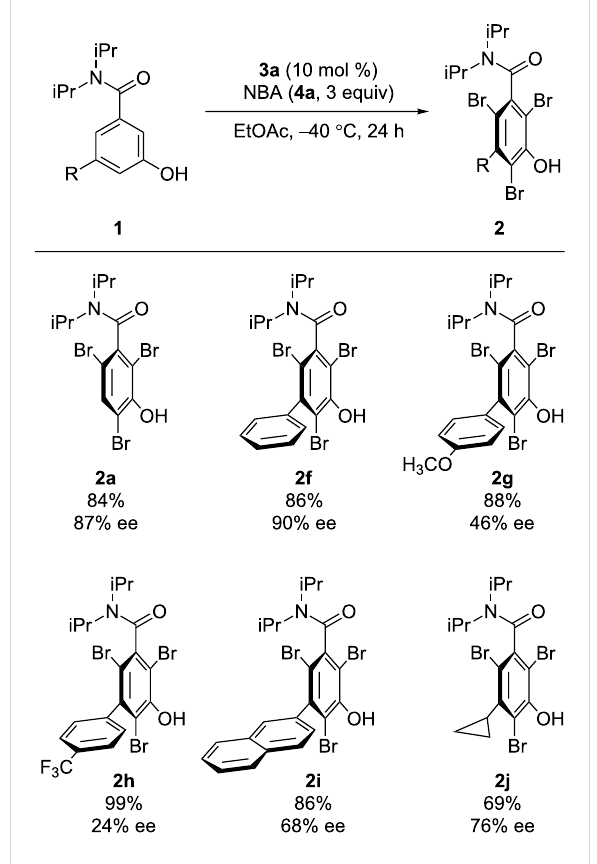
material isolated after silica gel column